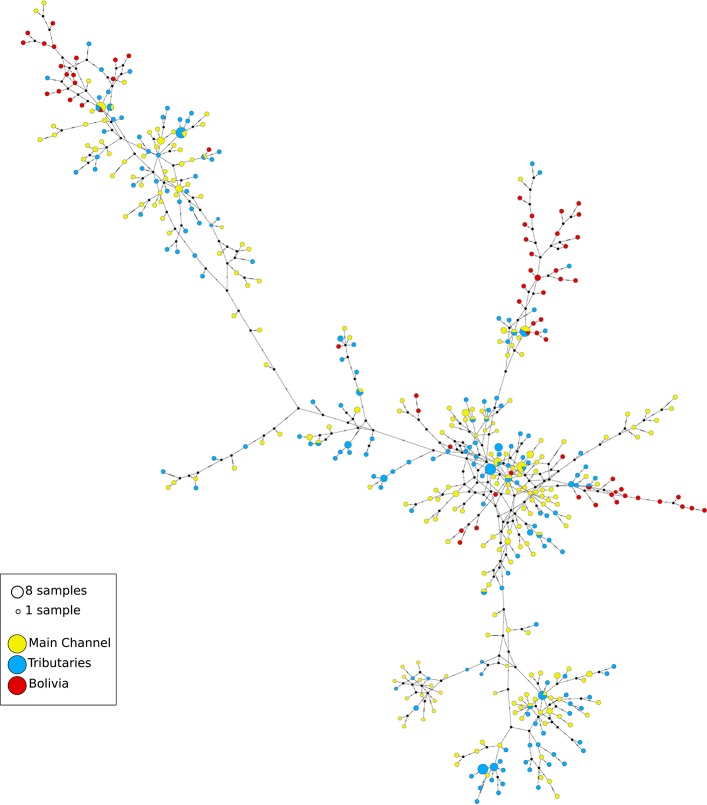
Haplotype network of Colossoma macropomum haplotypes estimated using Network. Each line represents a single mutation. Circle size correspond to the number of observations, and missing haplotypes remain unfilled. Colors corresponds to observation of a haplotype in one of three main regions (yellow = mainstream of Amazon River, blue = tributaries of the Amazon River, and red = Bolivian sub-basin).